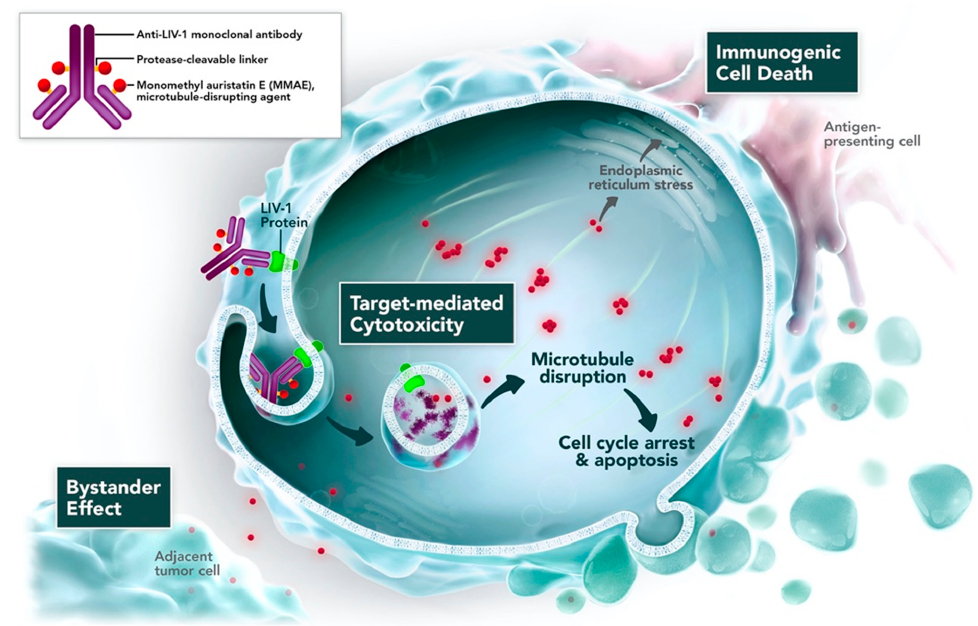
Figure 5. Mechanism of action of Ladrituzumab Vedotin. adapted from [92].